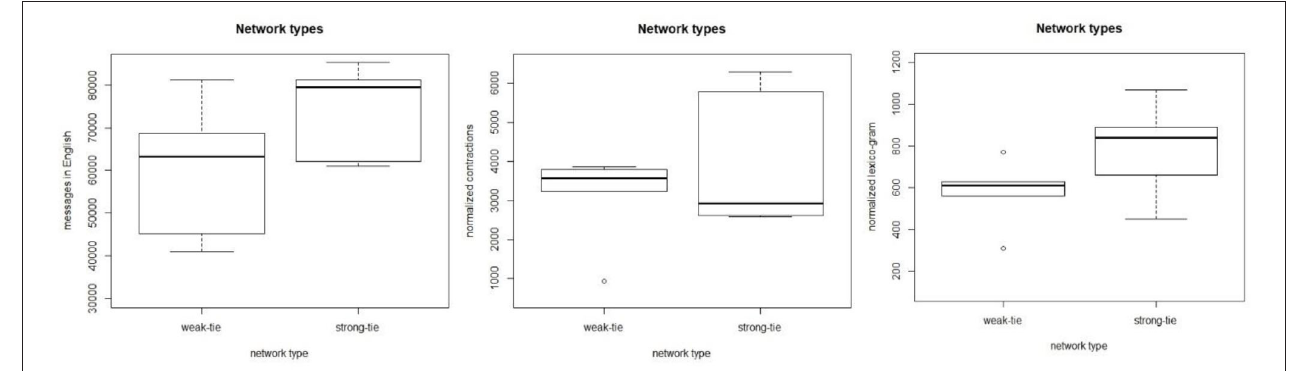
FIGURE 12 | The relationships between the network types and the dependent variables.